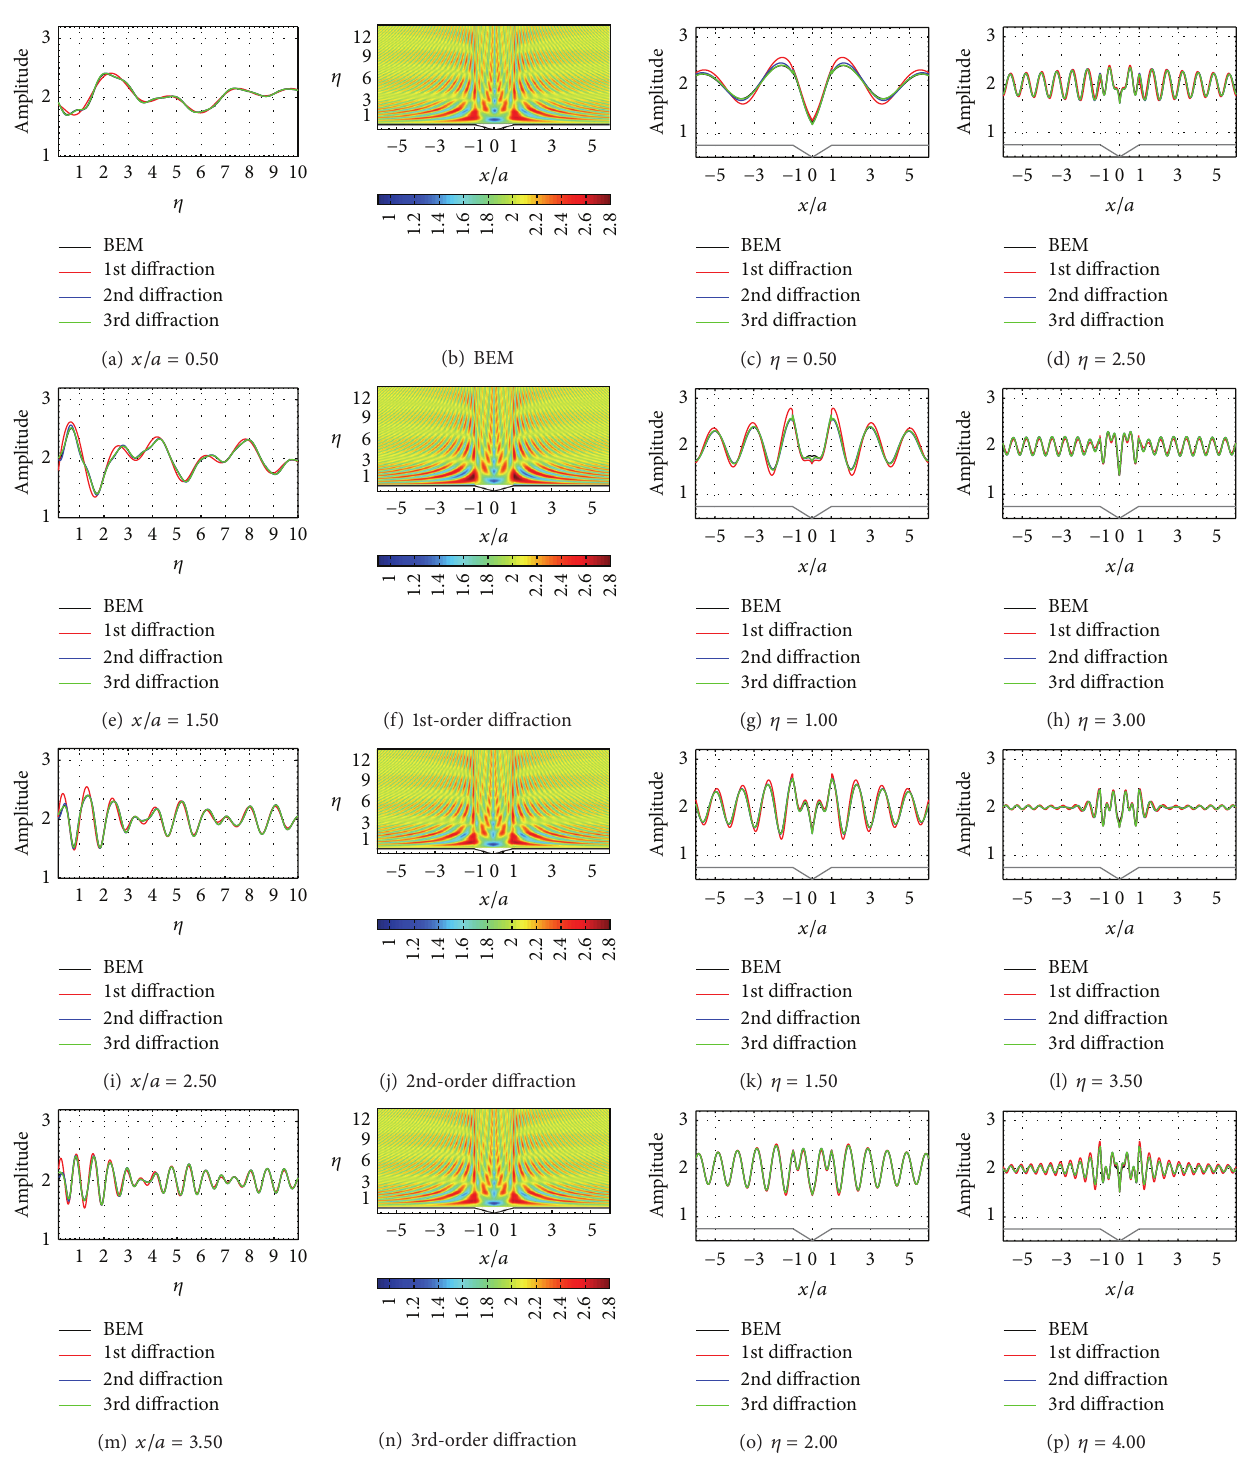
Figure 9: Frequency domain response for the V-shaped canyon topography. Column 2 displays frequency-space contour maps for the spatial distribution of the amplitude of the transfer function obtained with a BEM algorithm and with the current SBD technique with up to 3 orders of diffraction. Column 1 shows the amplitude functions at constant locations for different receivers over the canyon surface while columns 3 and 4 display the amplitude function for constant dimensionless frequencies and for receiver over the free